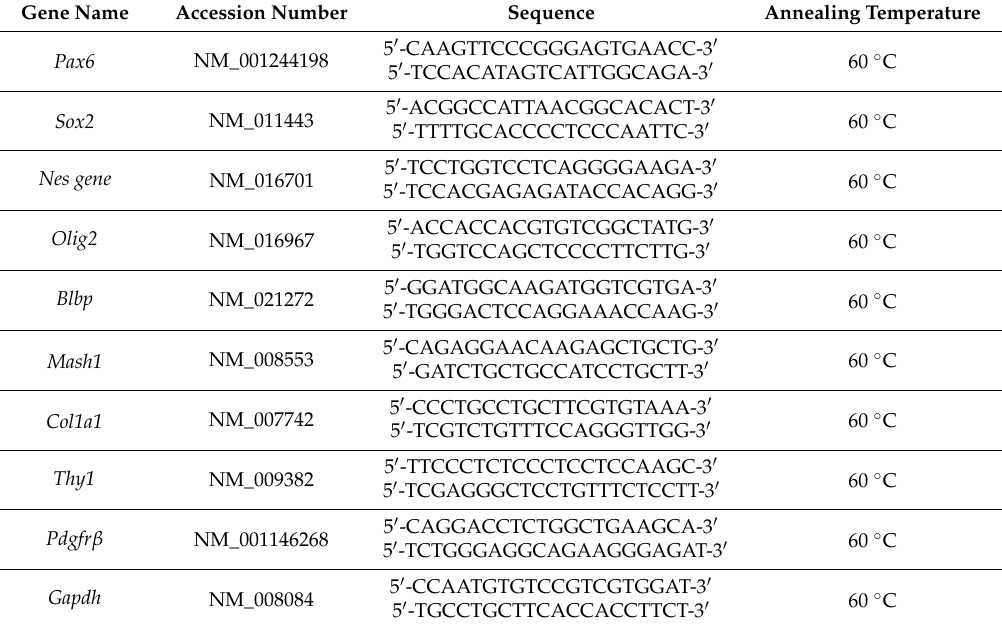
Table 1. Primers for